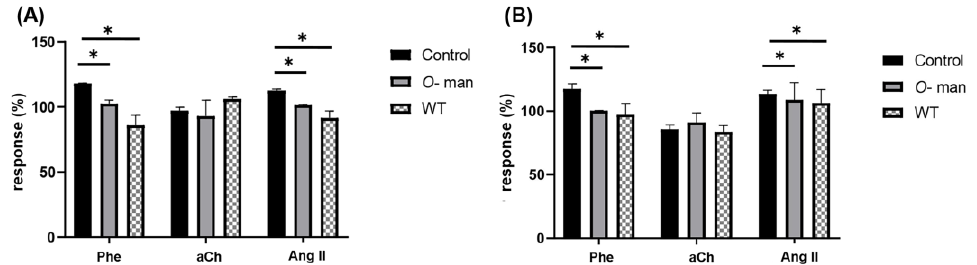
Figure 9. Modification of CPP and LVP in response to agonists when interacting isolated C. albicans mannans with coronary endothelium. Heart response, expressed as percentages of ( A ) CPP and ( B ) LVP, when Phe, aCh and Ang II are administered in the absence (Control) and in the presence of C. albicans N -linked mannans ( N -man) or C. albicans O -linked mannans ( O -man). Bars (mean ± SD) show the result of at least three independent experiments (* p < 0.05).